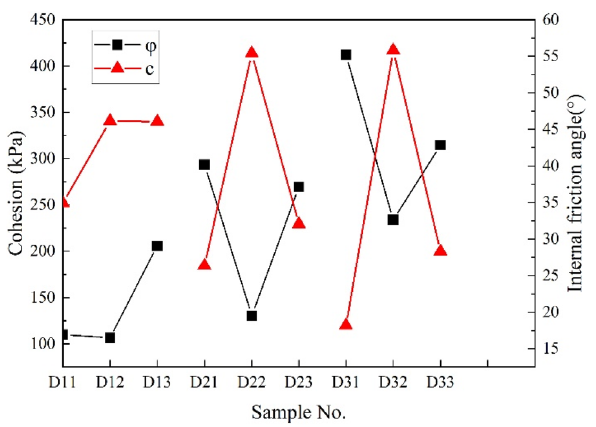
Figure 12. Curves on the cohesion and internal friction angle with different BF length and